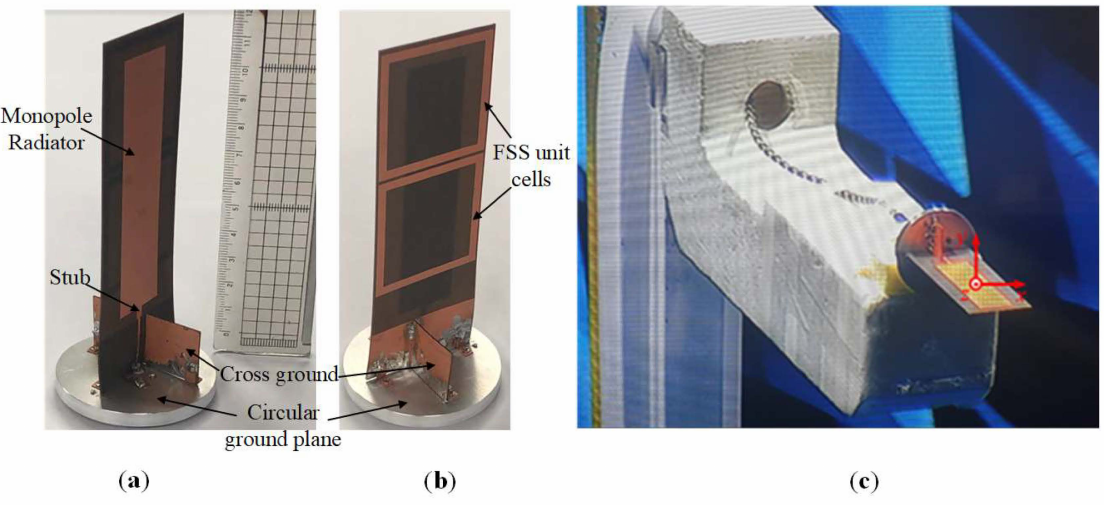
Figure 12. Photograph of the fabricated monopole antenna: ( a ) front view, ( b ) back view, and ( c ) far-field measurement